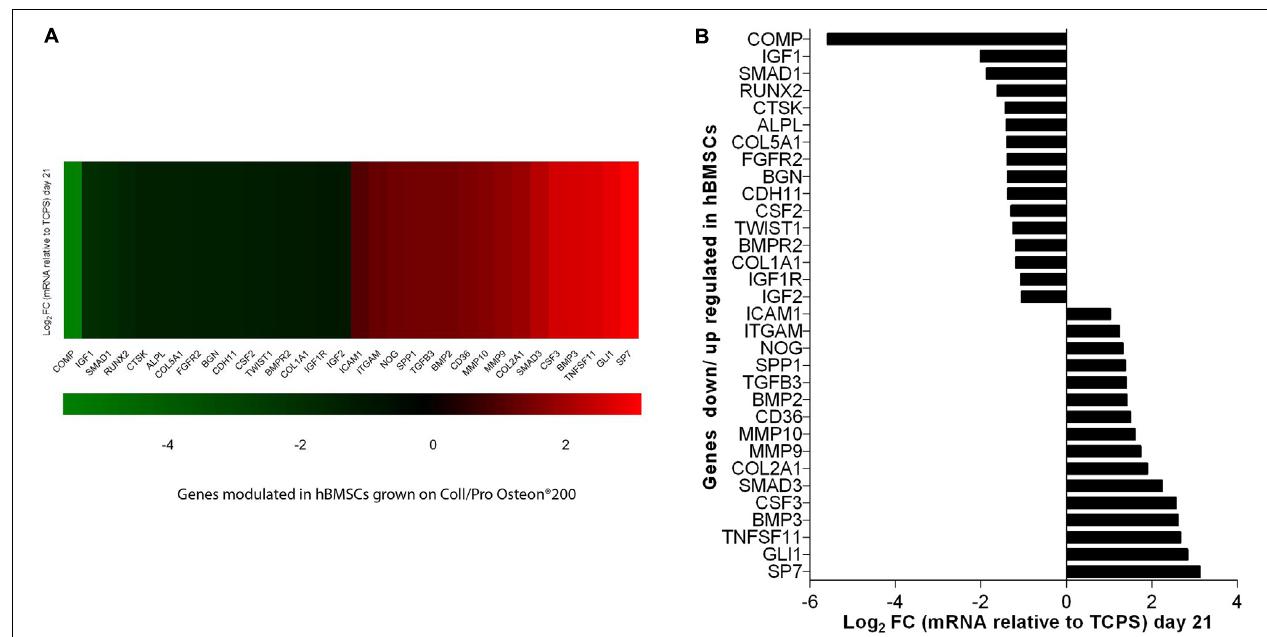
FIGURE 6 | PCR array analyses of osteogenic genes expression in human bone marrow-derived mesenchymal stem cells (hBMSCs) grown on Coll/Pro Osteon R (cid:13) 200 compared with tissue culture polystyrene (TCPS) reported at day 21. (A) Graphical representation through heat map of the mRNA expression in hBMSCs. The fold-change values (Log 2 < 1 or > 1) is represented as up-regulated (red) and down-regulated (green) genes in hBMSCs grown on Coll/Pro Osteon R (cid:13) 200 compared with the TCPS. (B) Graphical representation through bars of the mRNA expression in hBMSCs grown on Coll/Pro Osteon R (cid:13) 200 compared with TCPS. Over-expressed genes ( n = 16), at day 21, were transcription factor Sp7 (SP7); GLI family zinc finger 1 (GLI); TNF superfamily member 11 (TNFSF11); bone morphogenetic proteins 2 and 3 (BMP2 and BMP2 3); colony-stimulating factor 3 (CSF3); SMAD family member 3 (SMAD3); Collagen type II alpha 1 ( COL2A1 ); matrix metallopeptidases 9 and 10 (MMP9 and MMP10); CD36 molecule (CD36); transforming growth factor, beta 3 (TGFB3)/RANKL; secreted phosphoprotein 1 (SPP1), Noggin (NOG); integrin, alpha M (ITGAM); intercellular adhesion molecule 1 (ICAM1). Down-regulated gene ( n = 16) were cartilage oligomeric matrix protein (COMP); insulin growth factors 1 and 2 (IGF1, IGF2); SMAD family member 1 (SMAD1); runt-related transcription factor 2 (RUNX2); cathepsin K (CTSK), alkaline phosphatase (ALP); collagen type IV alpha 1 (COL5A1); fibroblast growth factor receptor 2 (FGFR2); biglycan (BGN); cadherin 11, type 2 (CDH11);